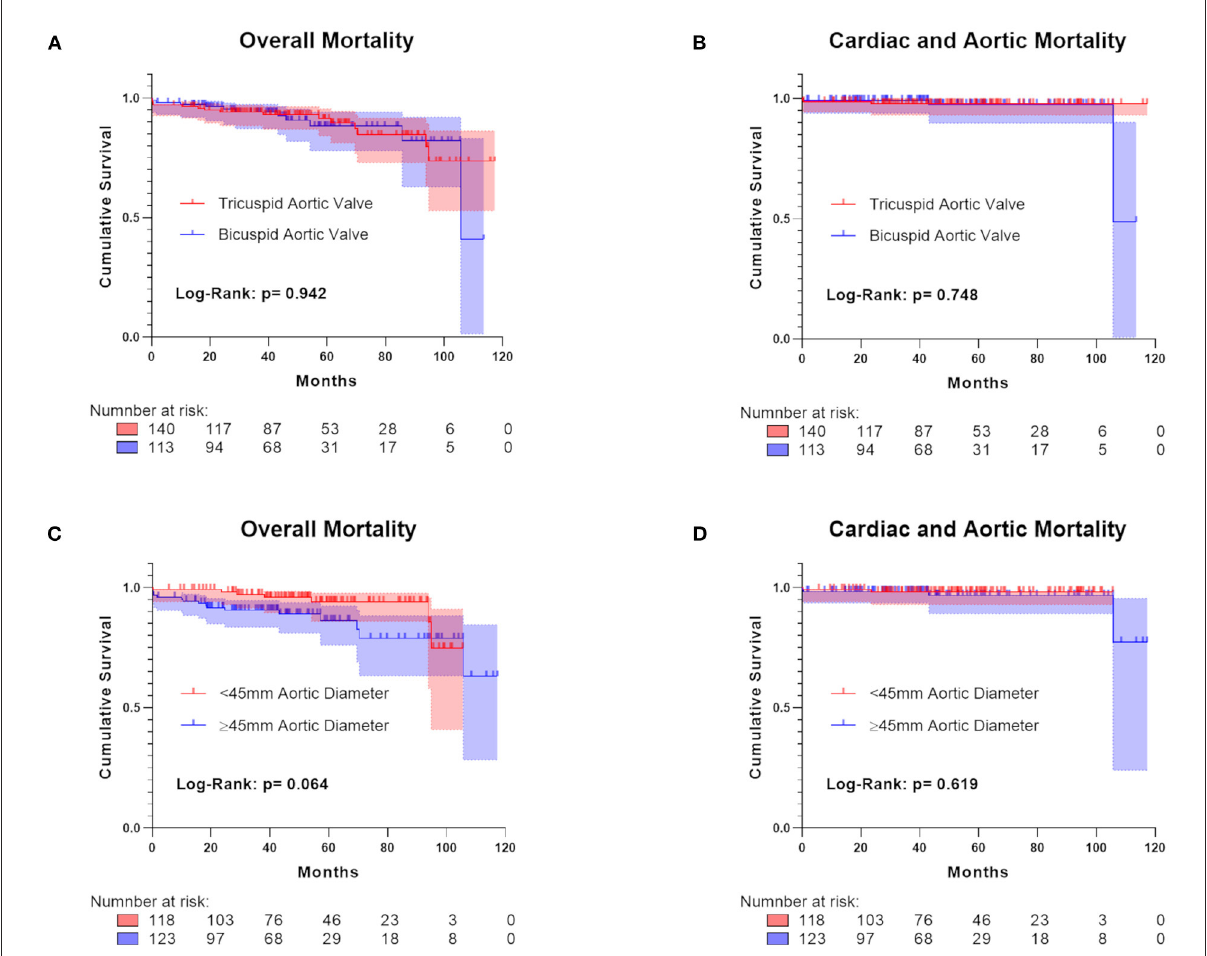
FIGURE2 Kaplan-Meier survival analyses regarding overall mortality and combined cardiac and aortic mortality between patients with tricuspid and bicuspid aortic valves (A,B) , and between patients with aortic diameters < 45 and ≥ 45mm (C,D)